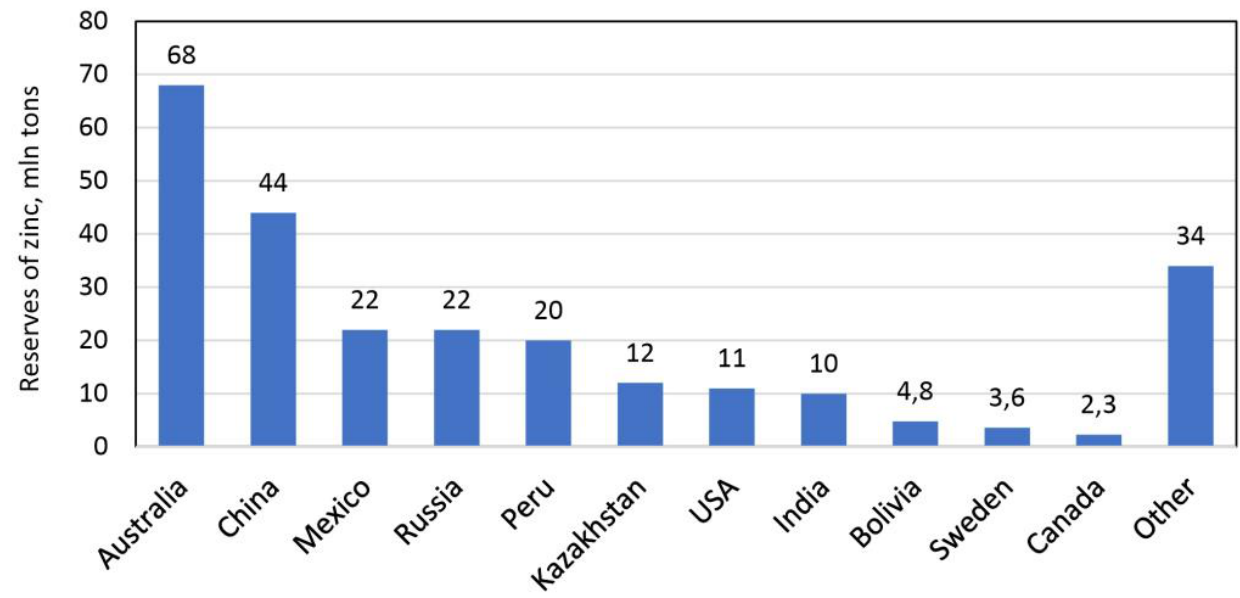
Figure 1. World reserves of zinc ore deposits in 2020, figure worked out based on data from [19].